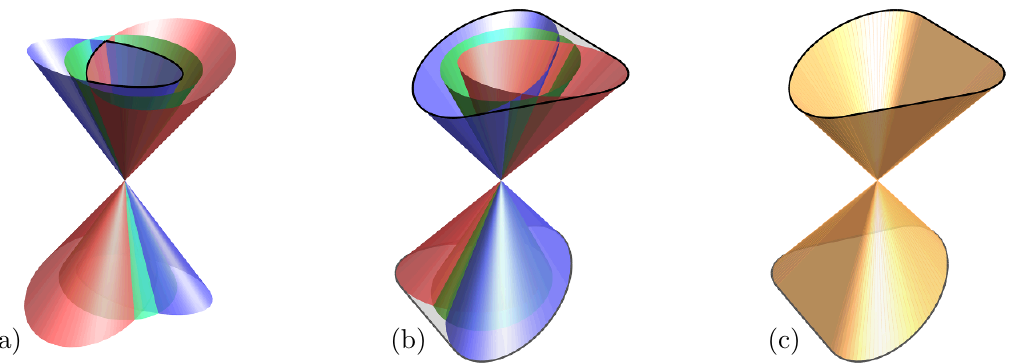
Figure 2 . The normal cone (a) of the evolution equations for the constraint violations in the cotangent space, and the corresponding ray cone (b) in the tangent space. The geometric mean cones (shown in green) are not part of the normal or the ray cone. The causal cone (c) is the convex hull of the causal cones of the two individual systems, which encloses the ray cones